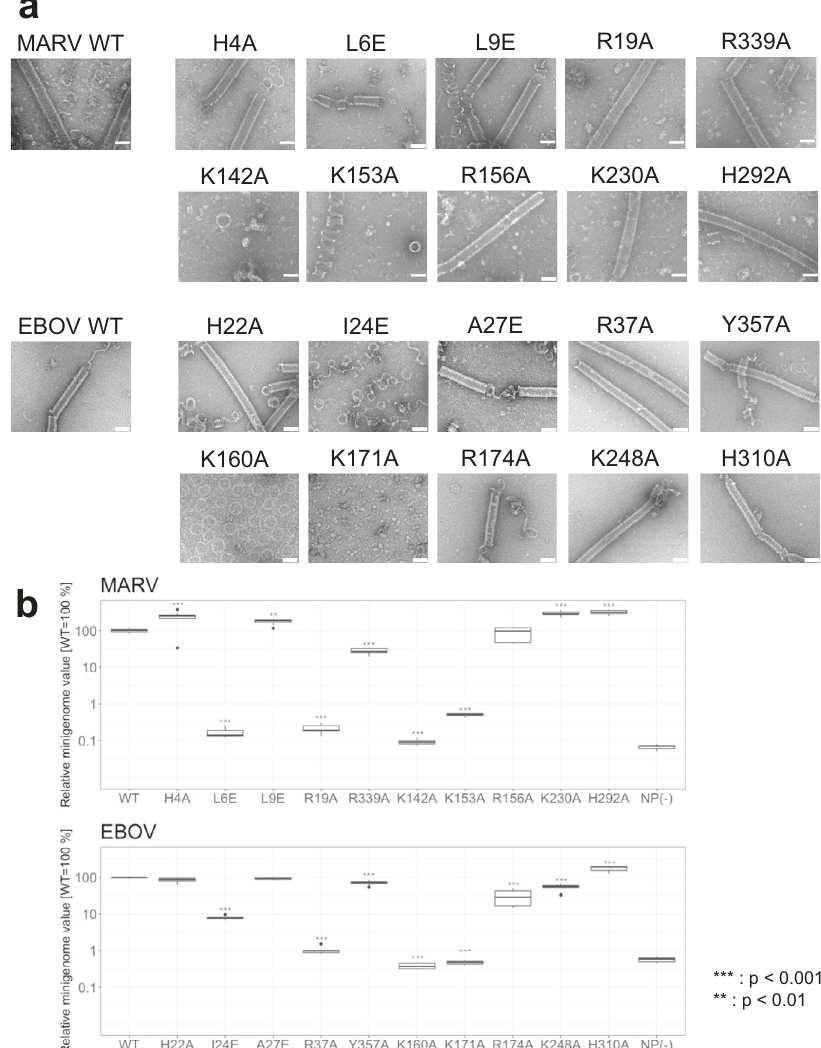
Fig. 4 Site-directed mutagenesis analysis. a A gallery of puri fi ed, negatively stained, helical complexes composed of C-terminally truncated MARV and EBOV NP mutant – RNA complexes and the wild-type (WT) complex. Scale bars, 50 nm. b Transcription and replication activities of MARV and EBOV NP mutants and the wild-type (WT), evaluated by minigenome assay. The experiments were performed in triplicates ( n = 3). The statistical signi fi cance was tested by two-sided ANOVA-Dunnett ’ s test to correct for multiple hypothesis testing. Box-and-whiskers plots represented the maxima, 75th percentile, median, 25th percentile, and minima, with a dot indicating the missing value. Source data are provided as a Source Data fi